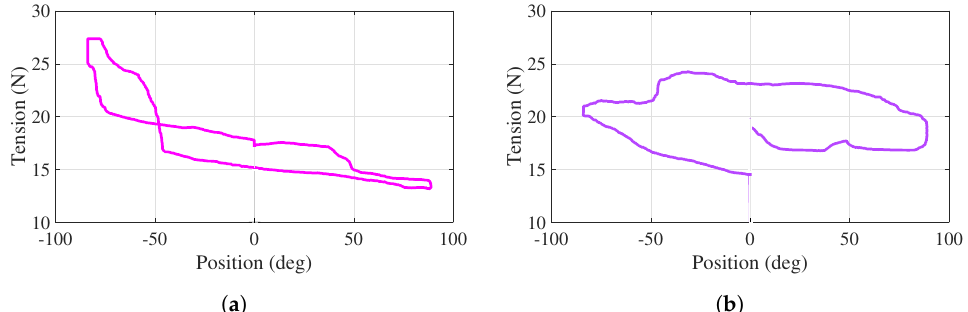
Figure 11. Active-assisted phase. Tensions as a function of the angular position ( a ) l 1 , l 3 . ( b ) l 2 , l 4 .